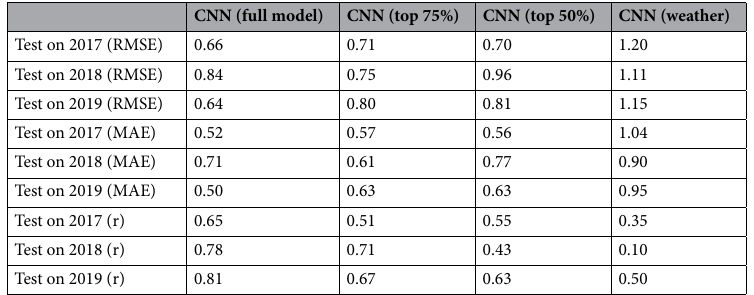
Table 2. Test results of using different subsets of features for predicting winter wheat yield with the proposed CNN